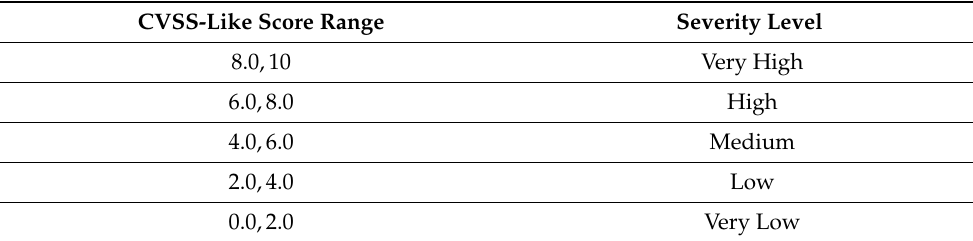
Table 5. CVSS score with corresponding vulnerability